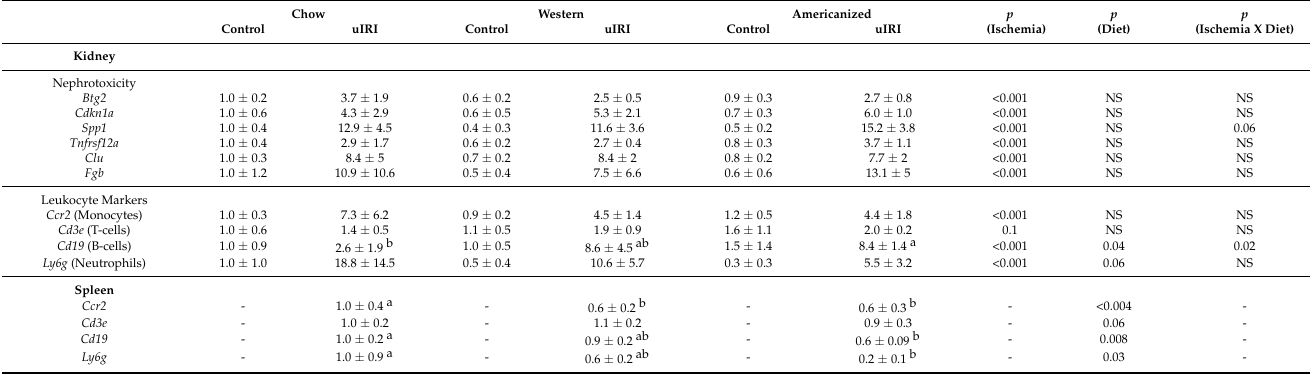
Table A5. RT-PCR data from diet-uIRI